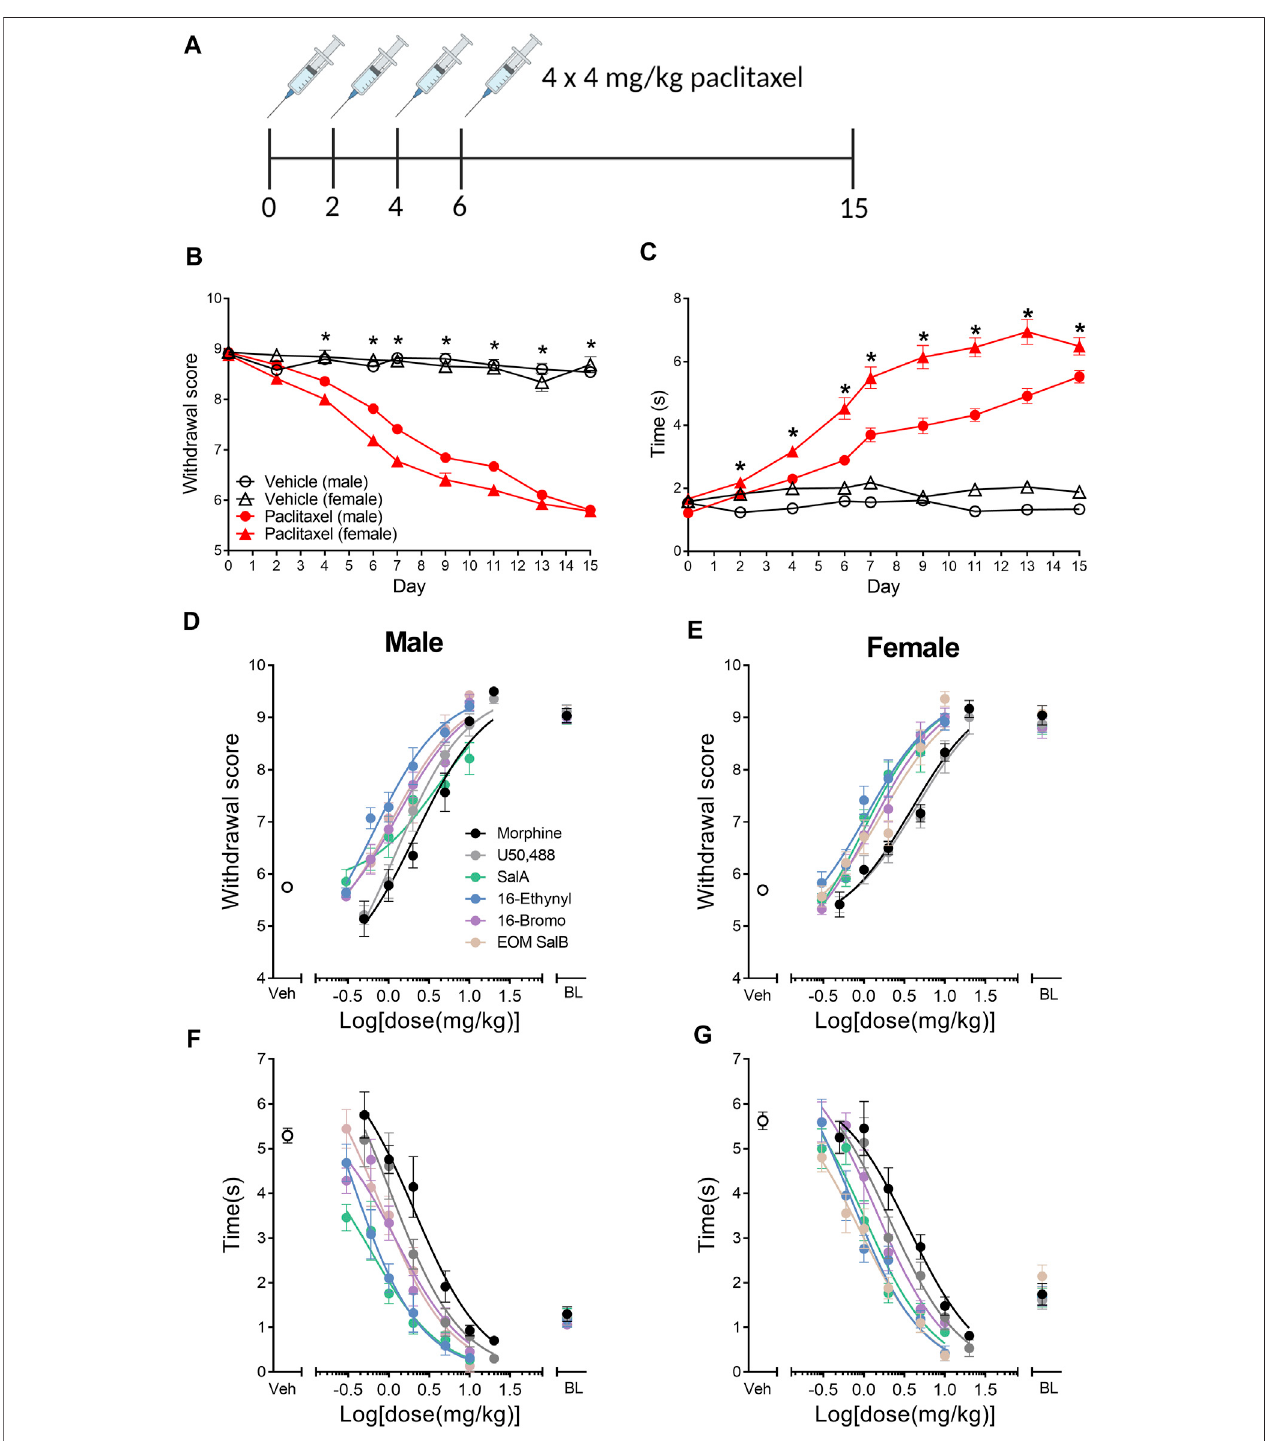
FIGURE 2 | Paclitaxel administration produces mechanical and cold allodynia in male and female C57BL/6J mice. (A) Paclitaxel was administered as 4 doses of 4 mg/kg and allodynia measured until day 15. Numbers underneath the timeline represent experimental days. (B) Paclitaxel administration produced mechanical allodynia on days 4 – 15, shown as a reduction in withdrawal score measured using von Frey fi laments. There were no sex differences in the withdrawal scores. (C) Paclitaxeladministrationhadasigni fi canteffectondays2 – 15,withanincreaseinreactiontimetoacoldacetonestimulus.Therewasaneffectoftreatmentandsex, and but no interaction of both factors, with females showing an increased reaction time in the vehicle and paclitaxel treatment groups compared to males. Three-way repeated measures mixed ANOVA. * p < 0.006. Vehicle-treated n = 16 – 18; paclitaxel-treated males n = 50, females n = 36. (D – G) Dose-response effects of morphine and the KOR agonists comparing male and female mice with established paclitaxel-induced neuropathic pain. Mechanical allodynia was measured in (D) males and (E) females. Cold allodynia was measured in (F) males and (G) females. Veh refers to paclitaxel-treated animals treated with vehicle. BL refers to pre-paclitaxel baseline values. n = 6 – 8. Values presented as mean ± SEM. Image in panel (A) created using BioRender.com.